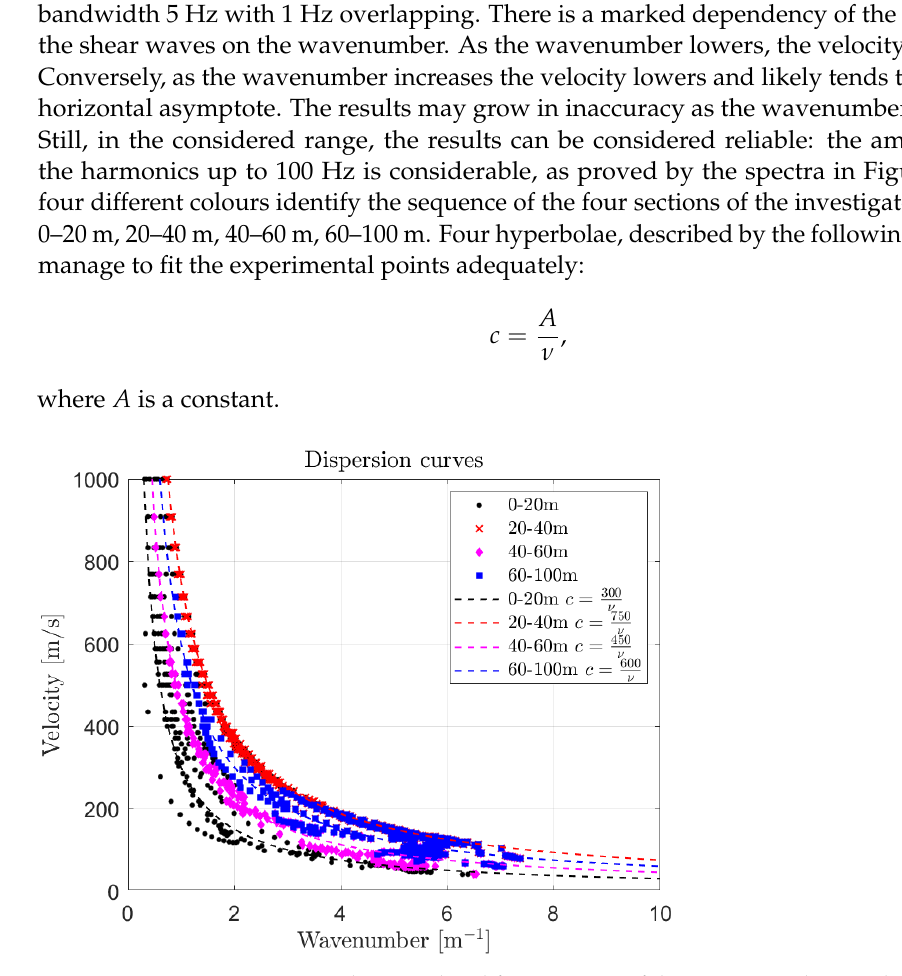
Figure 6. Dispersion curves in the considered four sections of the investigated